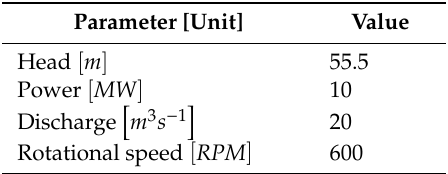
Table 1. Nominal operating parameters of the Porjus U9 prototype Kaplan turbine.